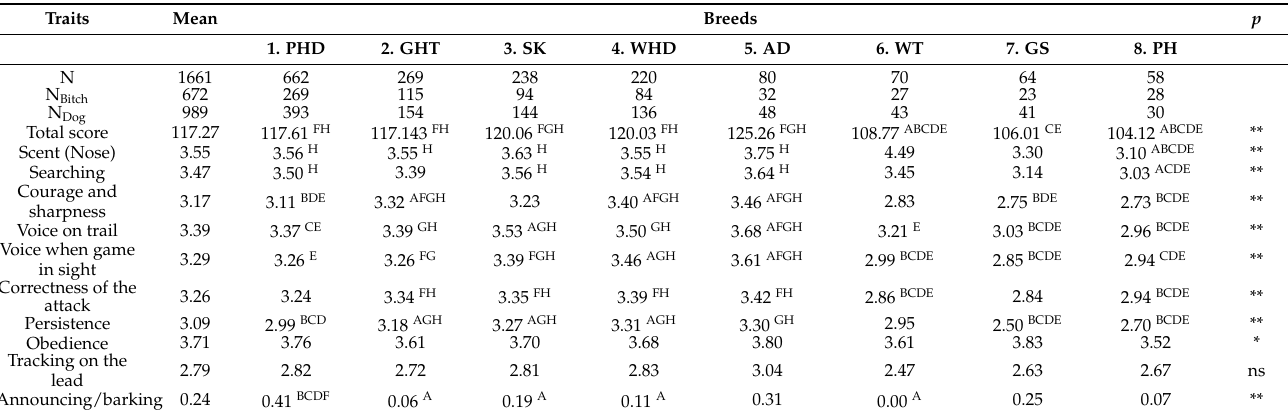
Table 5. The impact of breed on the results of the hunt trials for